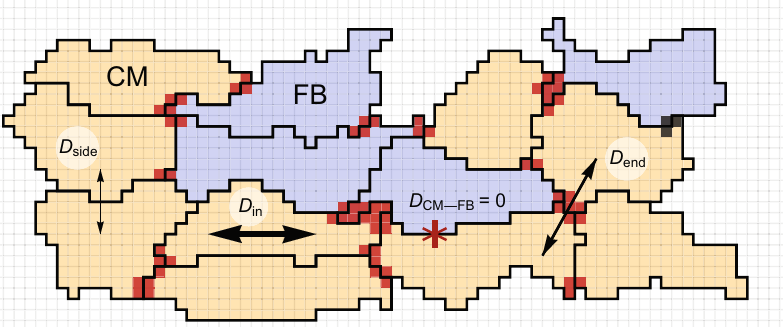
Figure 8. Algorithm for the coupling coefficient assignment. CMs are coloured in yellow, whereas FBs are coloured in blue. Dark red areas represent end–end type connections where the attachment sites in a GGH model are located. Between the red subcells of two different cells, the D coefficient was used. For all other end connections between cells, the coupling coefficient was D . For connections within a cell, the coupling side coefficient was D , and >  D D D . No coupling occurred between CM and FB in our in in end side